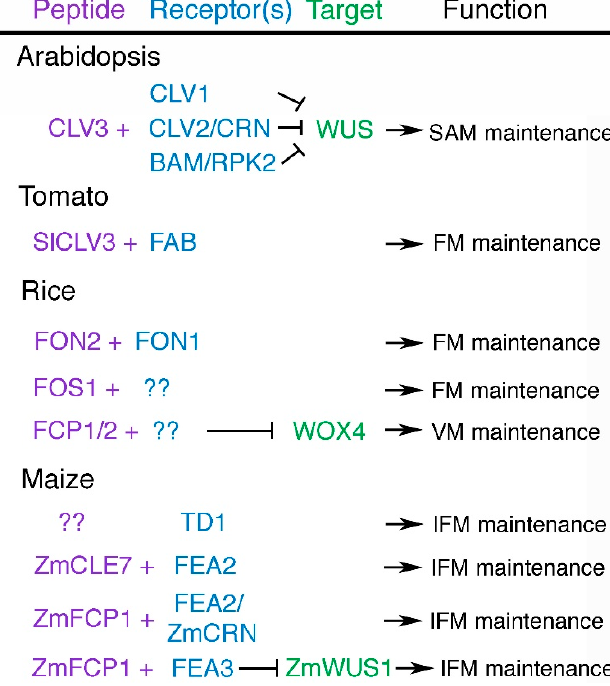
Figure 3. Components of CLV-WUS signaling pathways and their functions in model and crop plants. Proteins with characterized genetic and/or biochemical interactions are listed. Unidentified peptides and receptors are denoted by question marks. Arrows depict positive regulation and bars depict negative regulation. SAM, shoot apical meristem; FM, floral meristem; VM, vegetative meristem; IFM, inflorescence meristem.